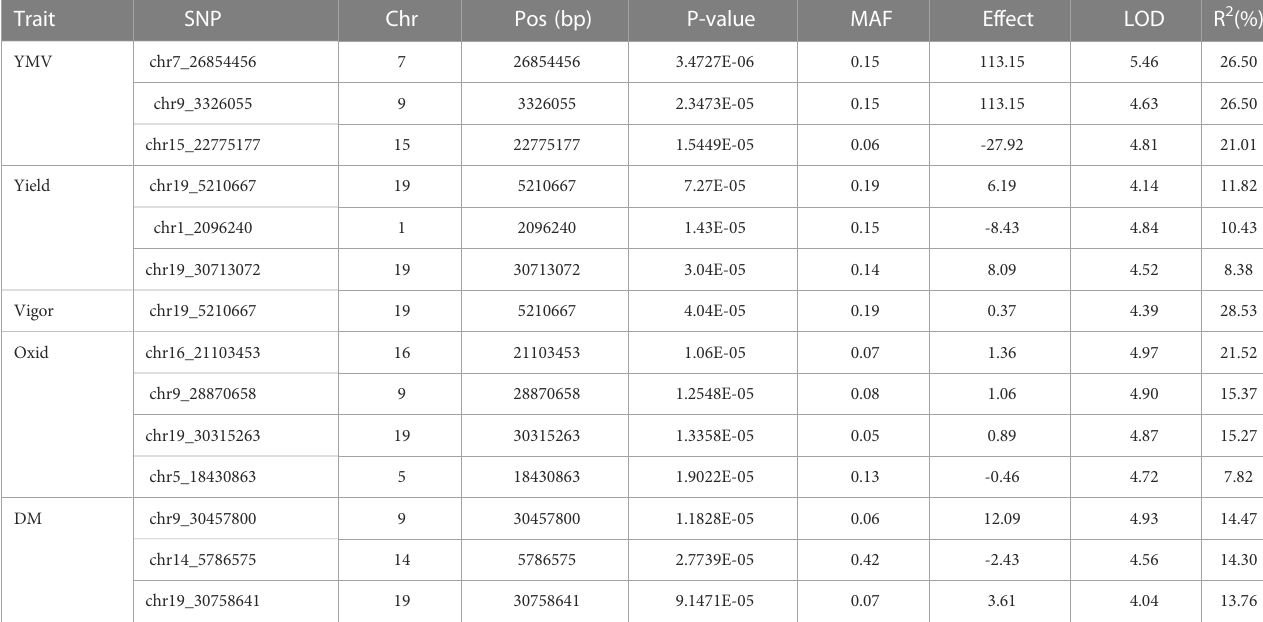
TABLE 5 SNP markers associated with target traits.